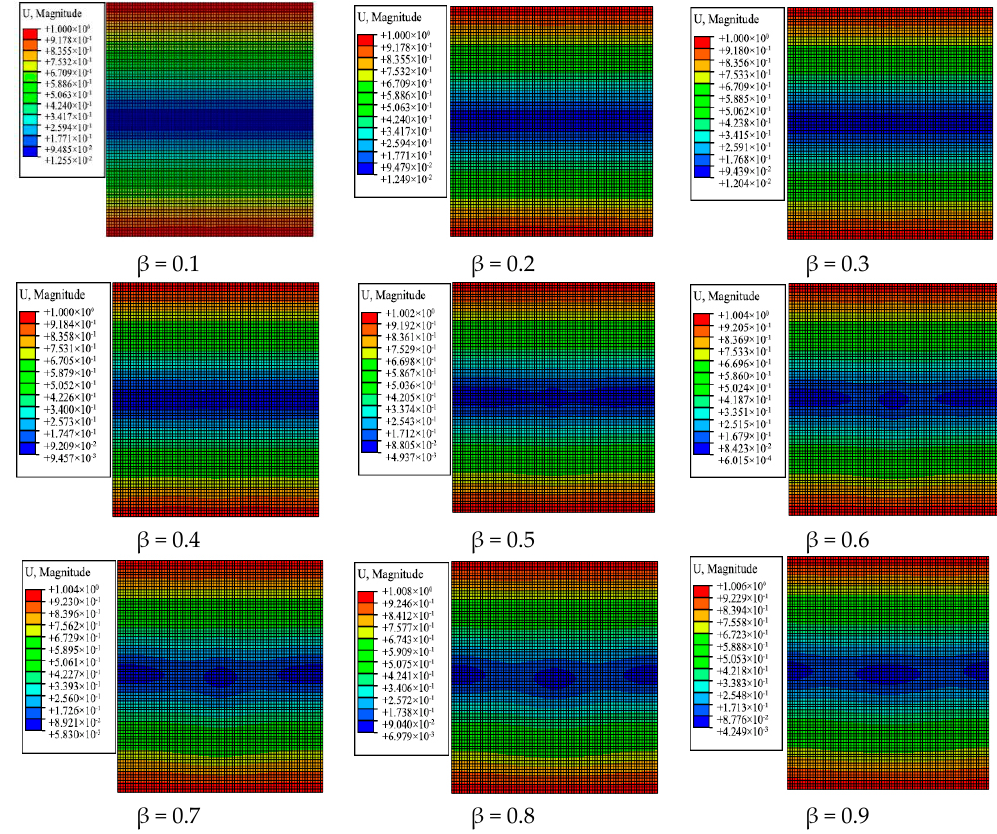
Figure 11. Deformation distribution nephogram of variable-angle laminates of [0 ± < 20 ( β ) 60 >] 2s .